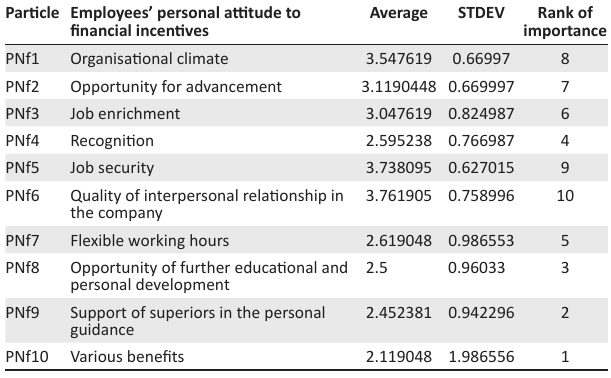
TABLE 8: Presence of non-financial incentives in the company.